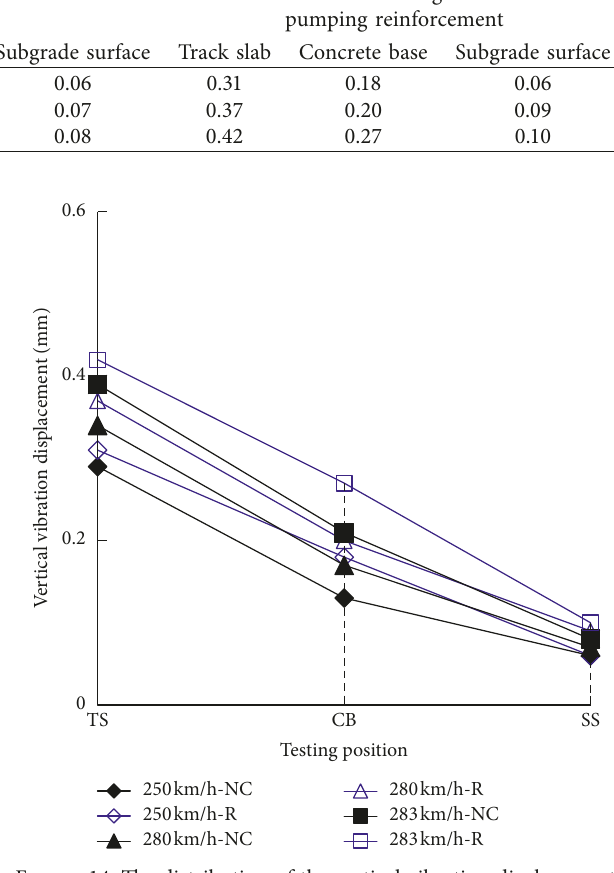
Figure 14: The distribution of the vertical vibration displacement of the ballastless track-subgrade without mud pumping and after mud pumping reinforcement.